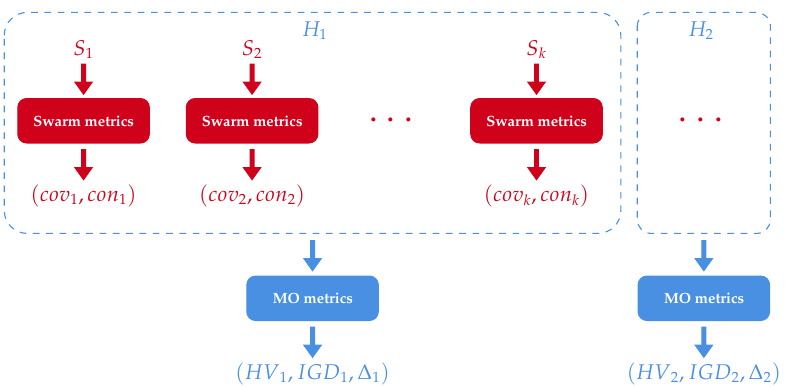
Figure 7. Usage of both swarm metrics and MO metrics to assess the performance of a